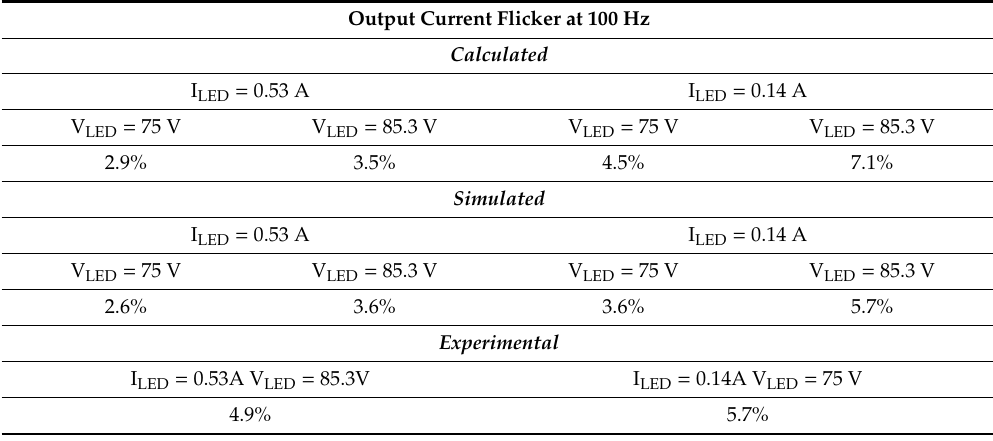
Table 3. Comparison between calculated, simulated and experimental LED current